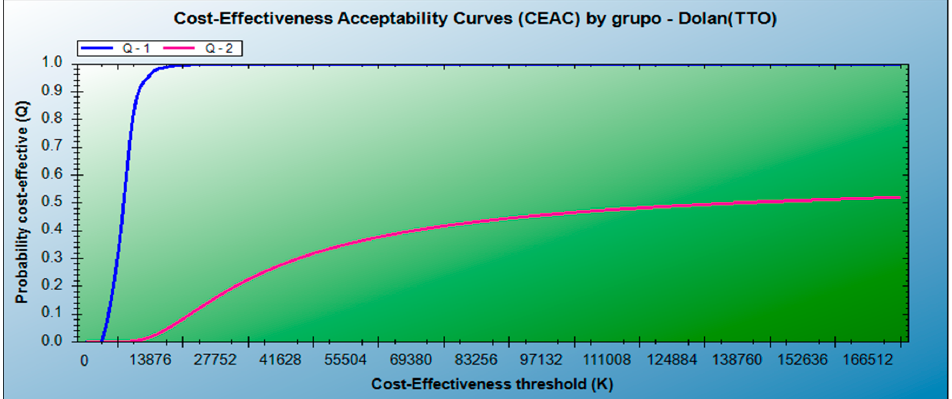
Figure 1. Cost-e ff ectiveness acceptability curves for Groups I and II following the Dolan (TTO) Figure 1. Cost-effectiveness acceptability curves for Groups I and II following the Dolan (TTO) methodology. Q-1, in blue, for Group I; Q-2, in pink, for Group methodology. Q-1, in blue, for Group I; Q-2, in pink, for Group II.